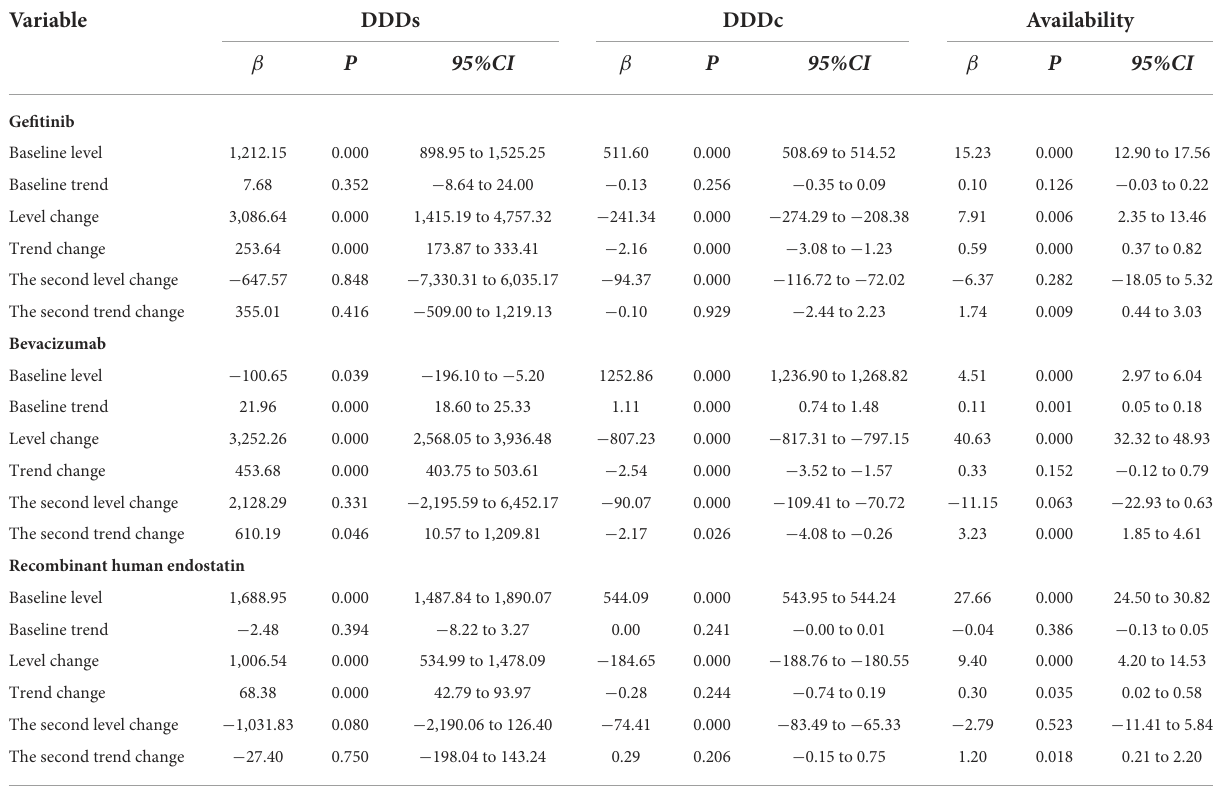
TABLE 2 Estimates from the multiple-treatment period’s analysis of the impact of health policies on the monthly DDDs, the monthly DDDc, and the availability of the three medicines. Variable DDDs DDDc